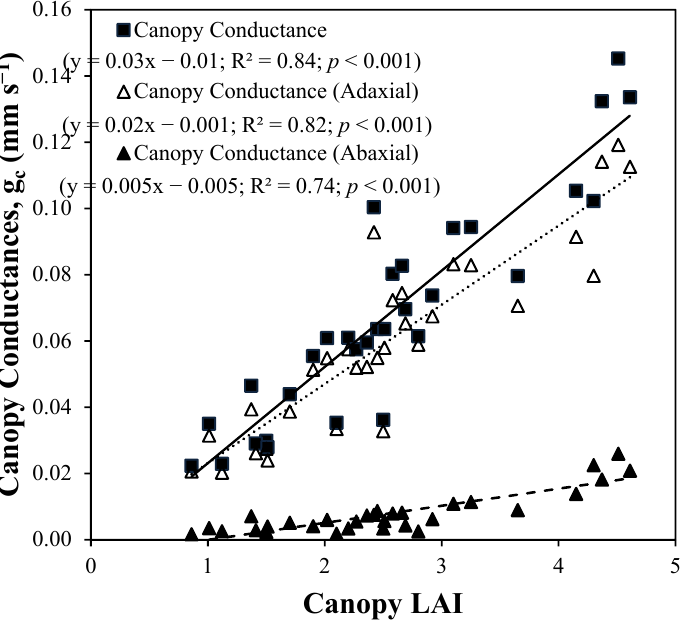
Figure 5. Measured canopy conductance, g c (mm s − 1 ) of adaxial ( △ , dotted trend line) and abaxial ( ▲ , dashed trend line) leaf surfaces, and net canopy conductance ( ■ , solid trend line) as a function of canopy LAI.